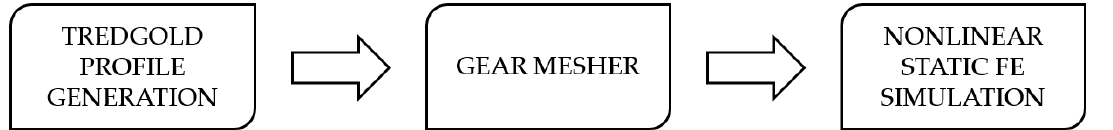
Figure 2. Logical sequence of the proposed semi-automated design method.